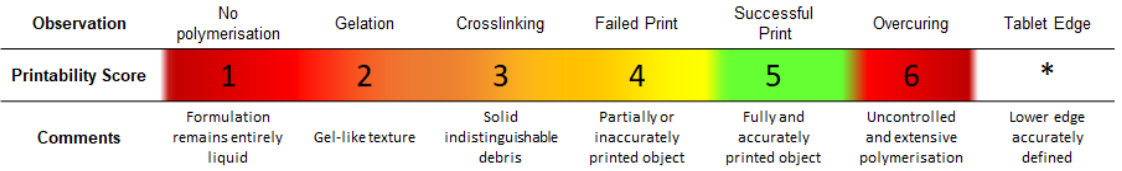
Figure 1. Printability scale designed to evaluate photopolymer formulations’ printability outcomes.